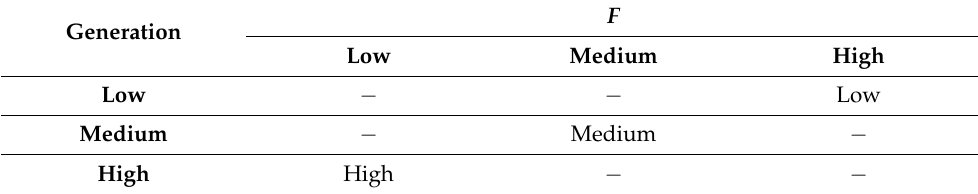
Table 1. Rules of the ST2FDE fuzzy